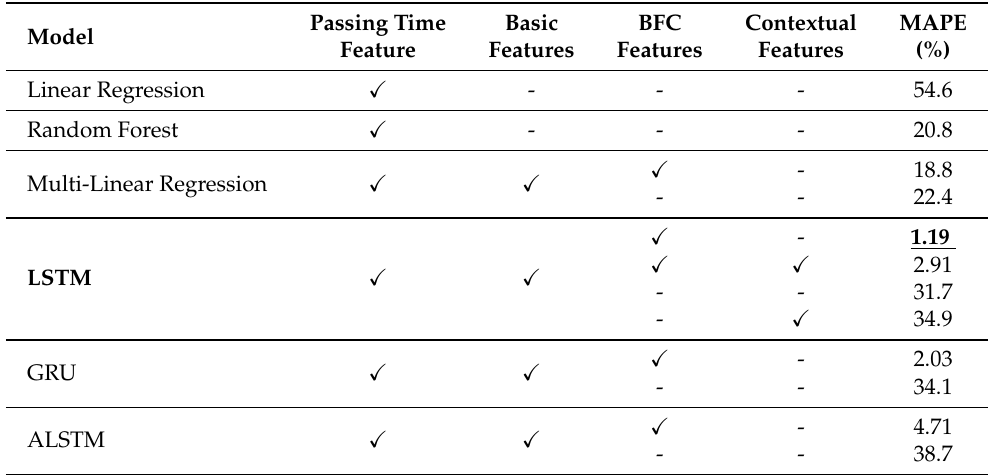
Table 3. Feature usage by modeling methods.